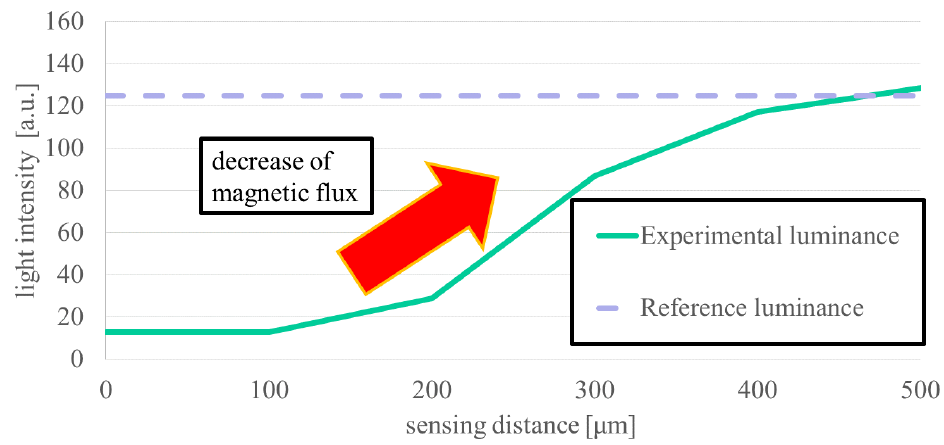
Figure 11. Relation between sensing distance and luminance by FEM analysis. The sensing ability has been reinforced and the limit is extended to around 500 μm.